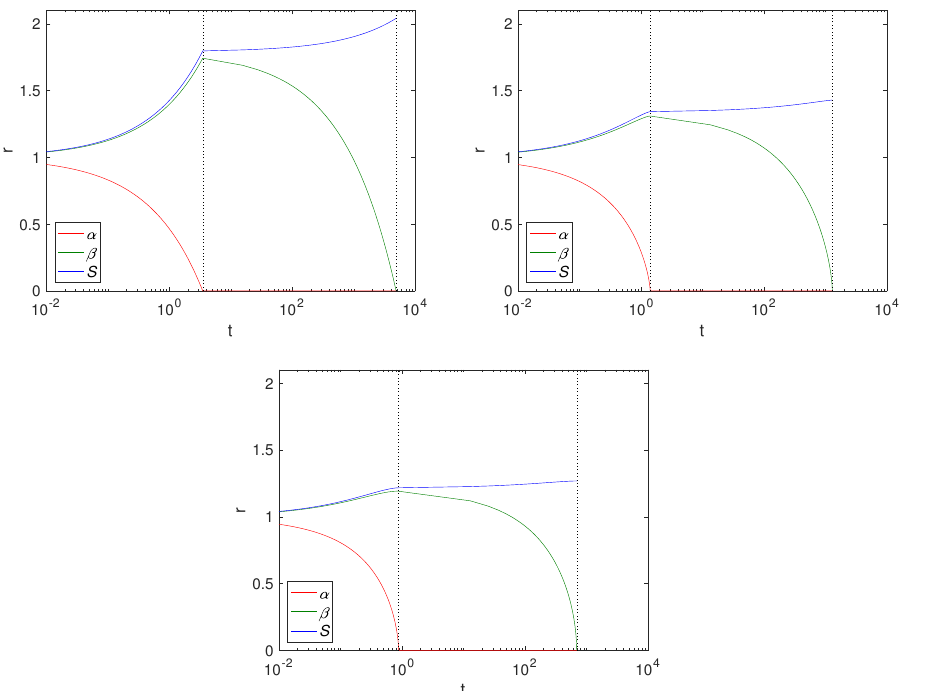
Figure 4. Plots of the dimensionsionless variables α , β and S against t , from left to right, Cartesian, cylindrical and spherical geometry using ε 1 = 0.6, ε 2 = 0.4, κ → ∞ , the parameters in Table 4 and S 0 = 1. The dashed lines show t = T α ( left ) and T β ( right